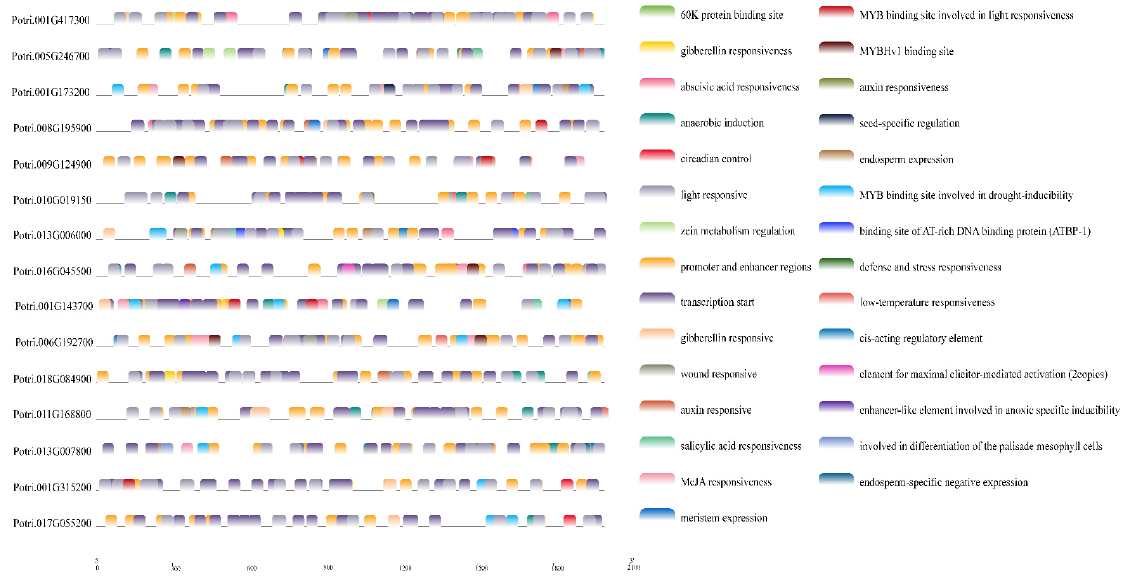
Figure 7. Cis ‐ elements of PtriZAT s interaction proteins during the 2000 bp upstream sequences. The color labels were on the right, the cis ‐ elements message seen on Table S9.